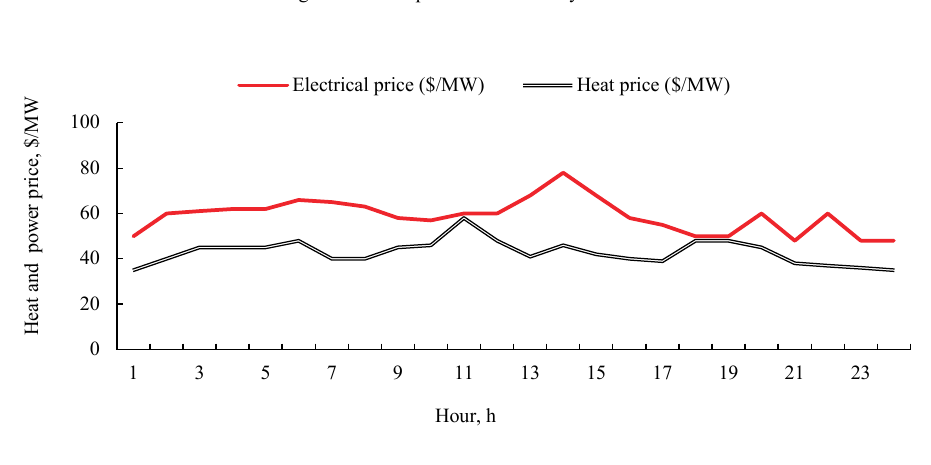
Fig. 2. Heat and power load of the system.